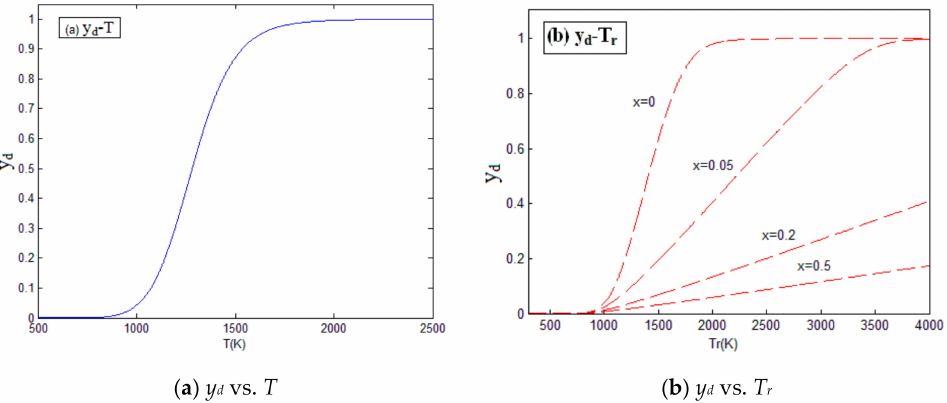
Figure 4. The relation between the degree of reaction and temperature. ( a ) The relation between the degree of reaction and temperature before material reaction; ( b ) The relation between the degree of reaction and temperature after material